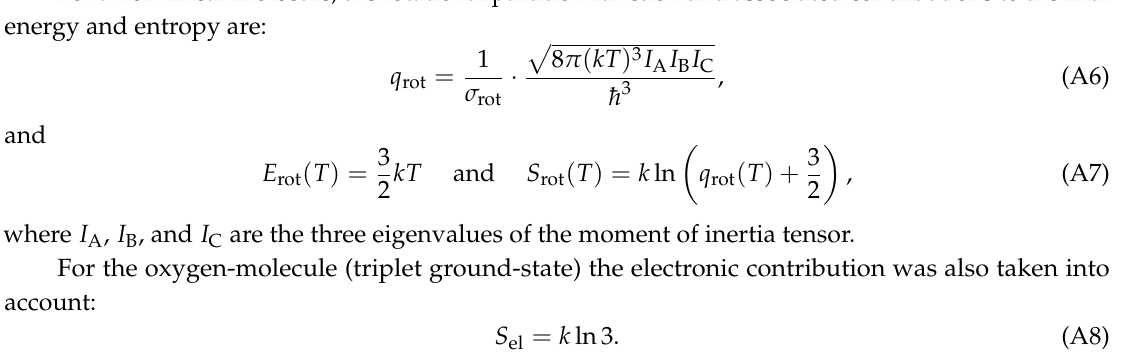
Figure A1. Surface energies of Önsten’s models A and B of the ( surface—the difference between the two models is that model A contains Cu CUS ions—compared to surface energies of other surfaces, which are shown as faded. Notice that the model A is predicted to be the least stable among the considered surface models, which is in agreement with GGA+U calculations of Bendavid and Carter